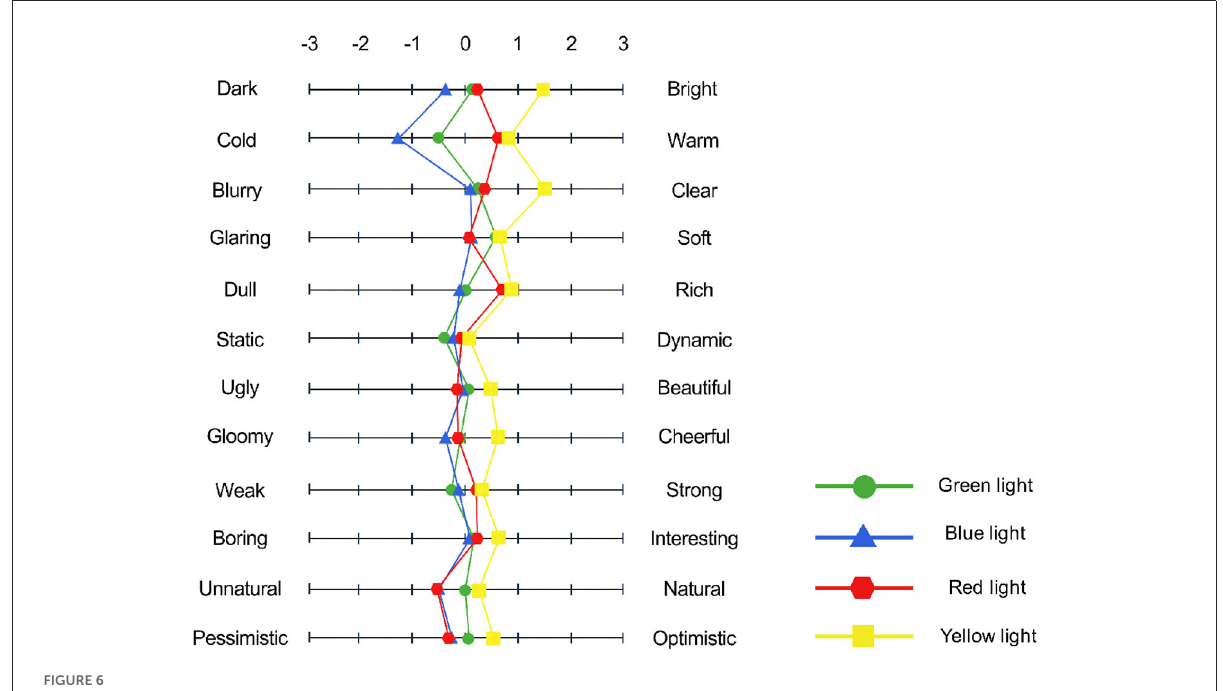
FIGURE6 Degree of Semantic Differential